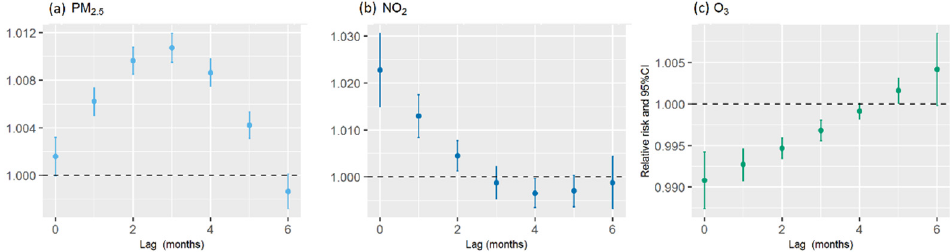
Figure 4. Lag-specific relative risks (%) of pulmonary tuberculosis (PTB) for 10-unit increases in the mean monthly concentrations of air pollutants based on single-pollutant models. ( a ) Air pollutant: PM 2.5 . ( b ) Air pollutant: NO 2 . ( c ) Air pollutant: O 3 .